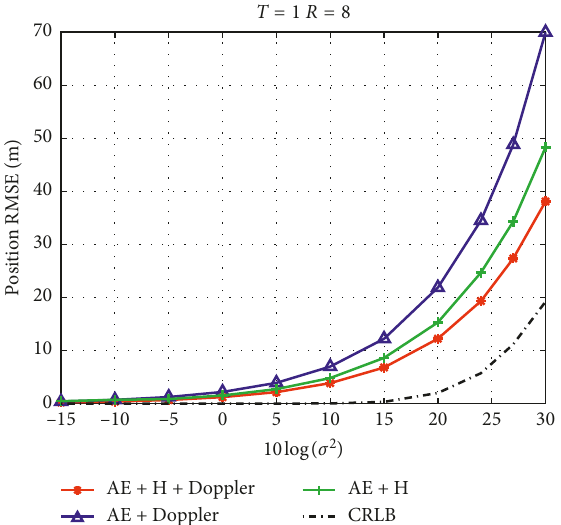
Figure 2: Comparison of the position RMSE of the proposed method with AE+Doppler, AE +H, and CRLB when T � 1, R � 8. The accuracy is lower as the noise power